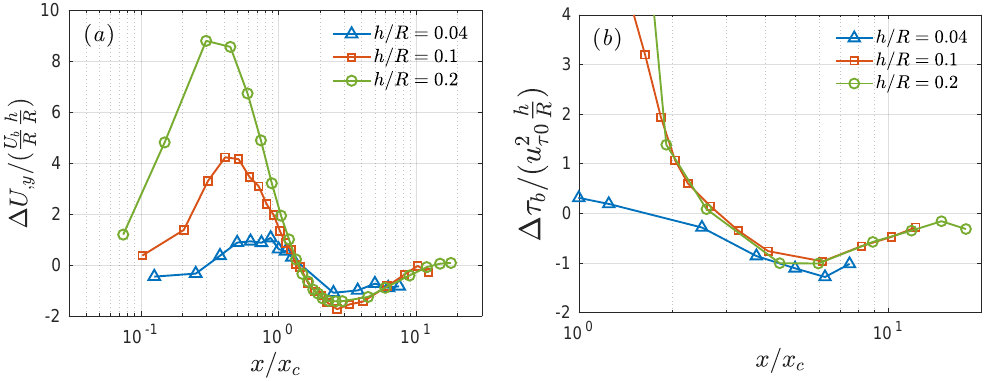
Figure 9. Development of ( a ) ∆ U , y and ( b ) ∆ τ b in terms of x / x c in the final stage of relaxation. Here, U , y denotes the wall-normal derivative of U , i.e., U , y = ∂ U / ∂ y .